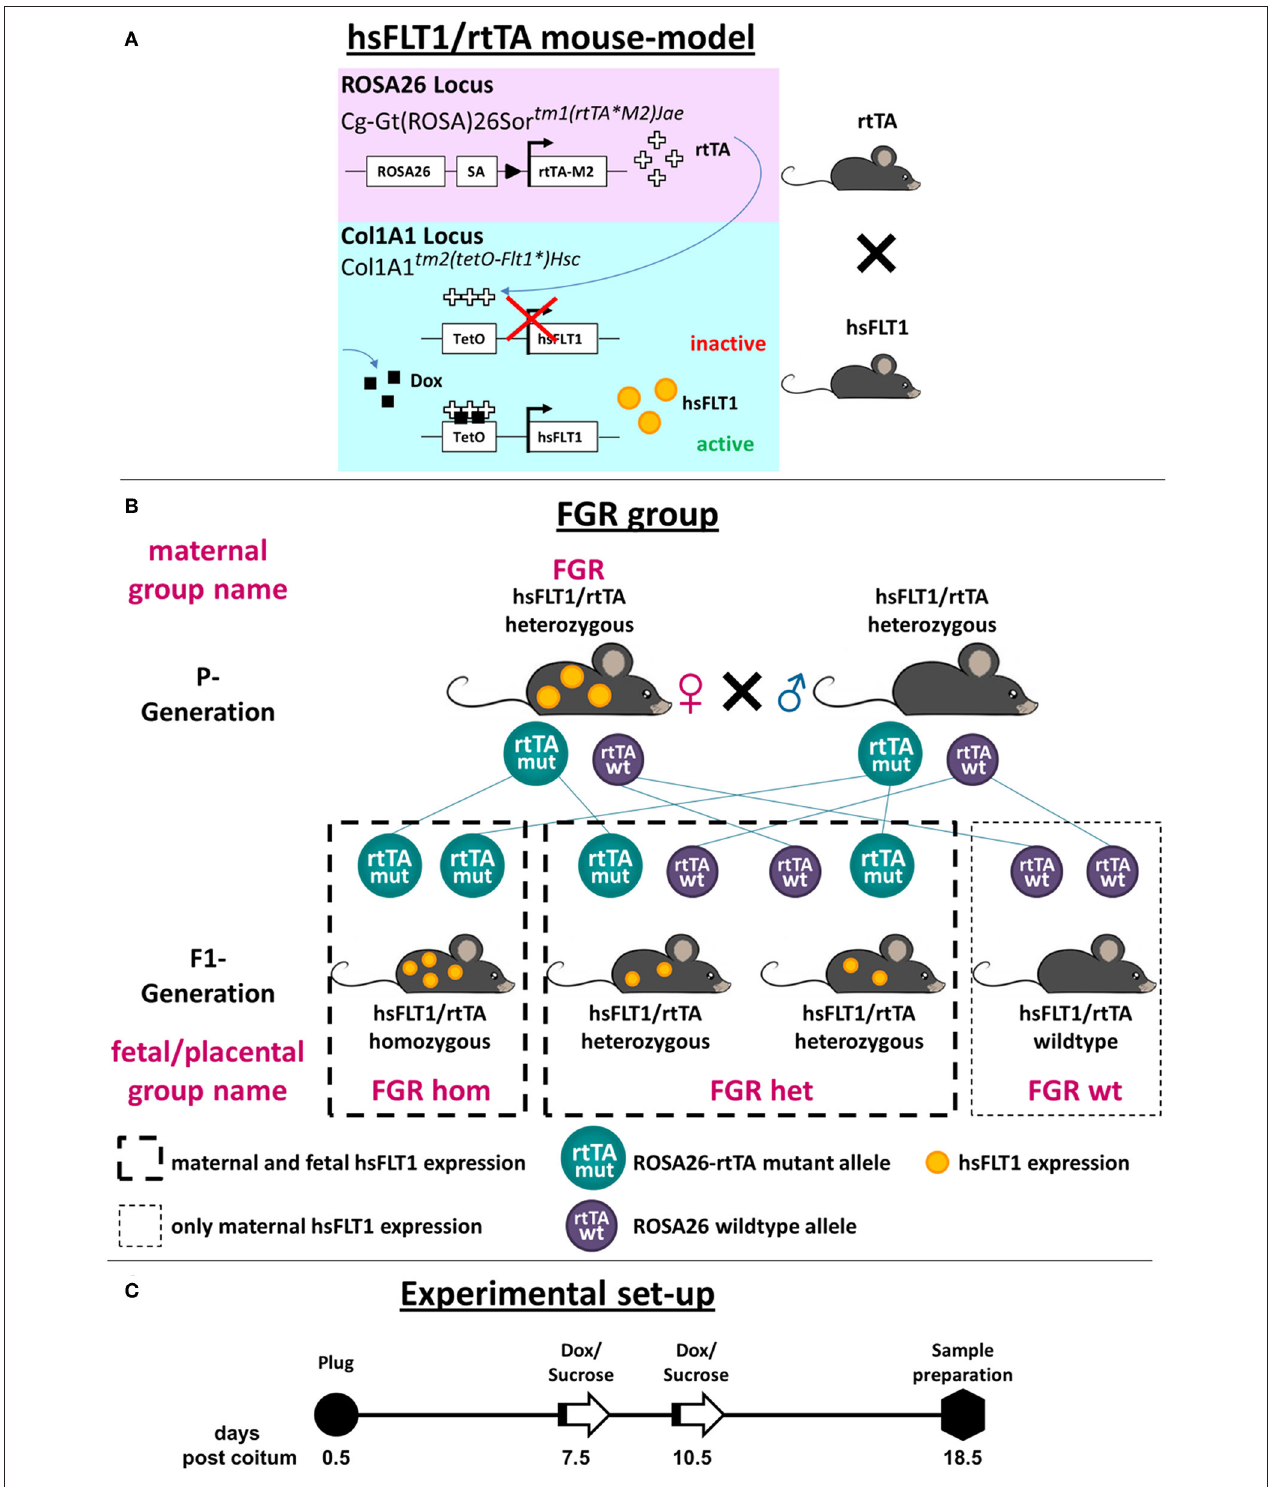
FIGURE 1 | Generation of the hsFLT1/rtTA mouse model with ubiquitous overexpression of hsFLT1. (A) We mated single transgenic Gt(ROSA)26Sor tm 1( rtTA * M 2) Jae mice with single transgenic Col1a1 tm 2( tetO − Flt 1 * ) Hsc mice to generate double transgenic human soluble fms-like tyrosine kinase 1 reverse tetracycline-controlled transactivator (hsFLT1/rtTA) mice. These mice ubiquitously express rtTA, which induces hsFLT1 expression upon treatment with doxycycline